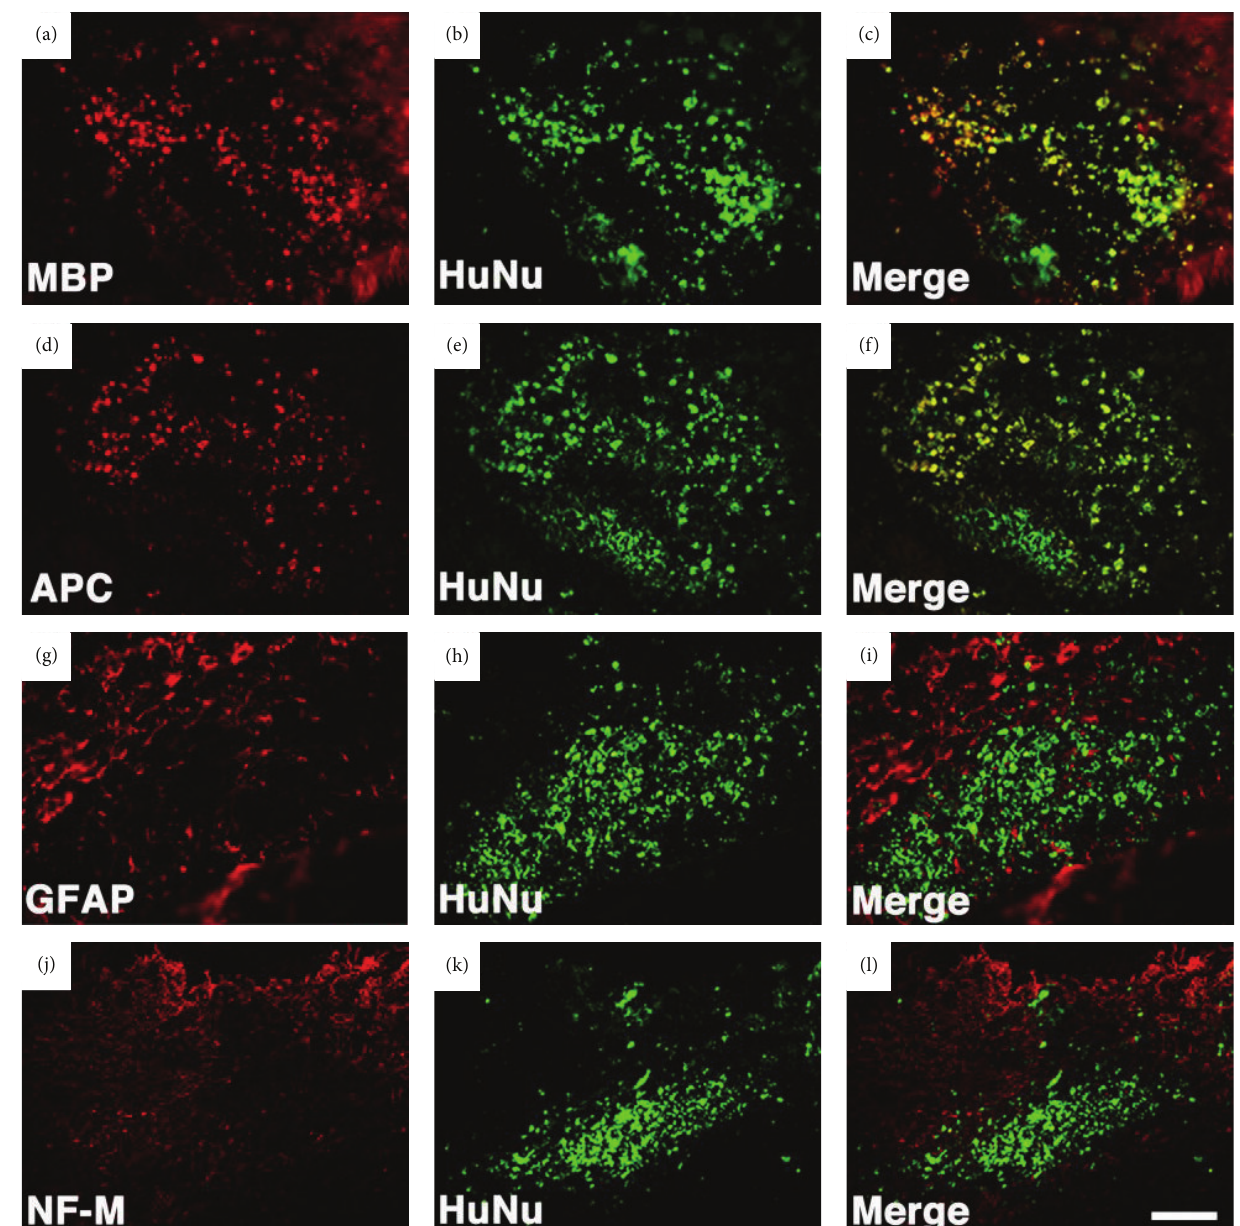
Figure 2: Immunohistochemical staining showed that SHED transplanted into transected spinal cord differentiated into mature oligodendrocytes [8] (Copyright (2012) American Society for Clinical